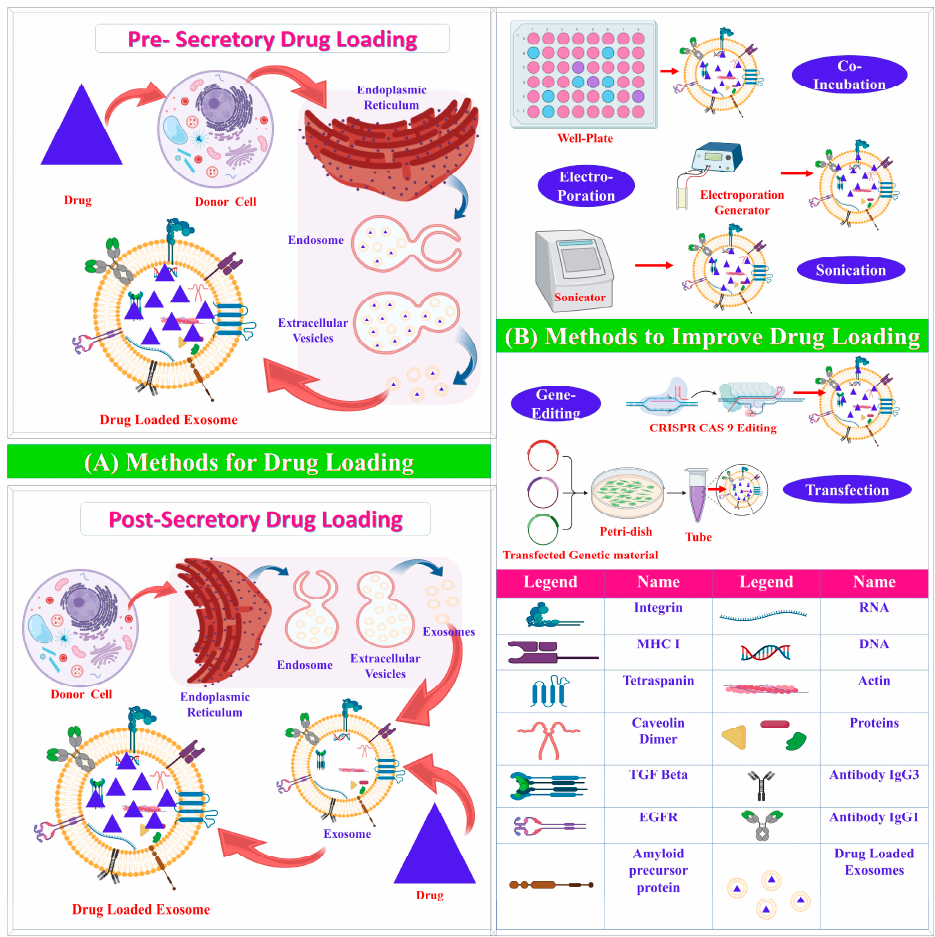
Figure 3. ( A ) Pre-secretory and post-secretory exosome drug-loading techniques and ( B ) methods of drug-loading enhancement. Pre-secretory drug loading, carried out before exosome secretion, involves (1) the incubation of the parent cell with the drug (transfection) and (2) gene editing. Post-secretory drug loading, carried out after exosome secretion, generally works in two ways: (1) passive incubation of the drug with the exosomes to allow the drug to attach to the exosome lipid bilayer membrane, or (2) the use of mechanical or chemical techniques, such as sonication and electroporation, to momentarily weaken the exosome membrane integrity to allow for the diffusion of the drug into the extracellular vesicles. The illustration was cre6ated with BioRender.com (https://app.biorender.com; accessed on 16 January 2023).